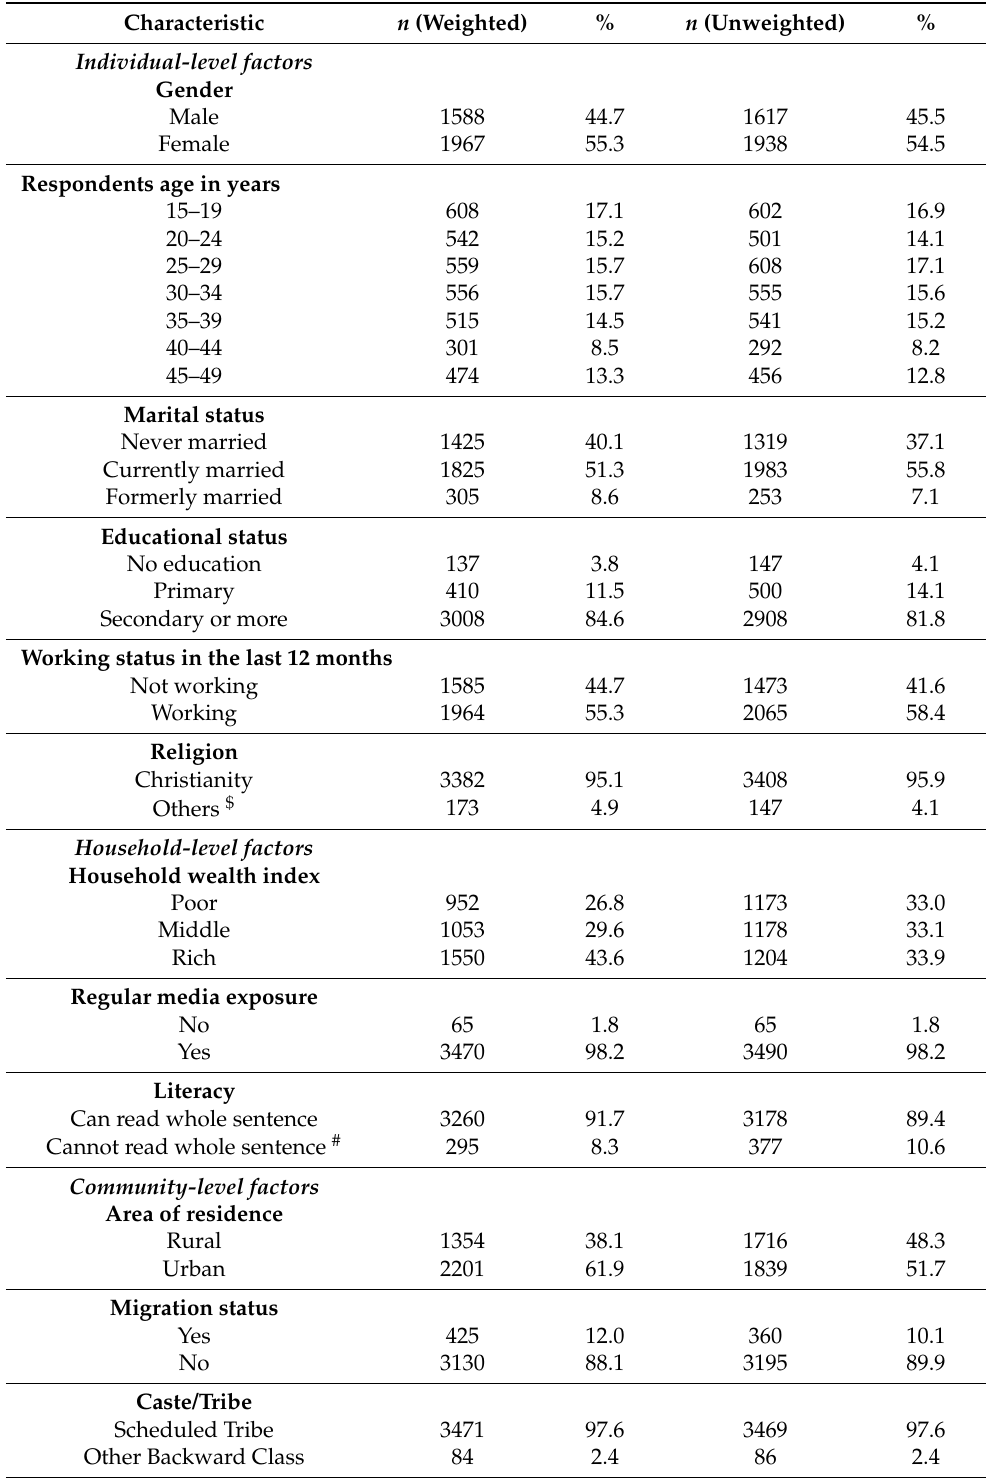
Table 1. Individual, household and, community-level characteristics of HIV/AIDs among adults aged 15–49 years in Mizoram, India 2015–2016 ( n =